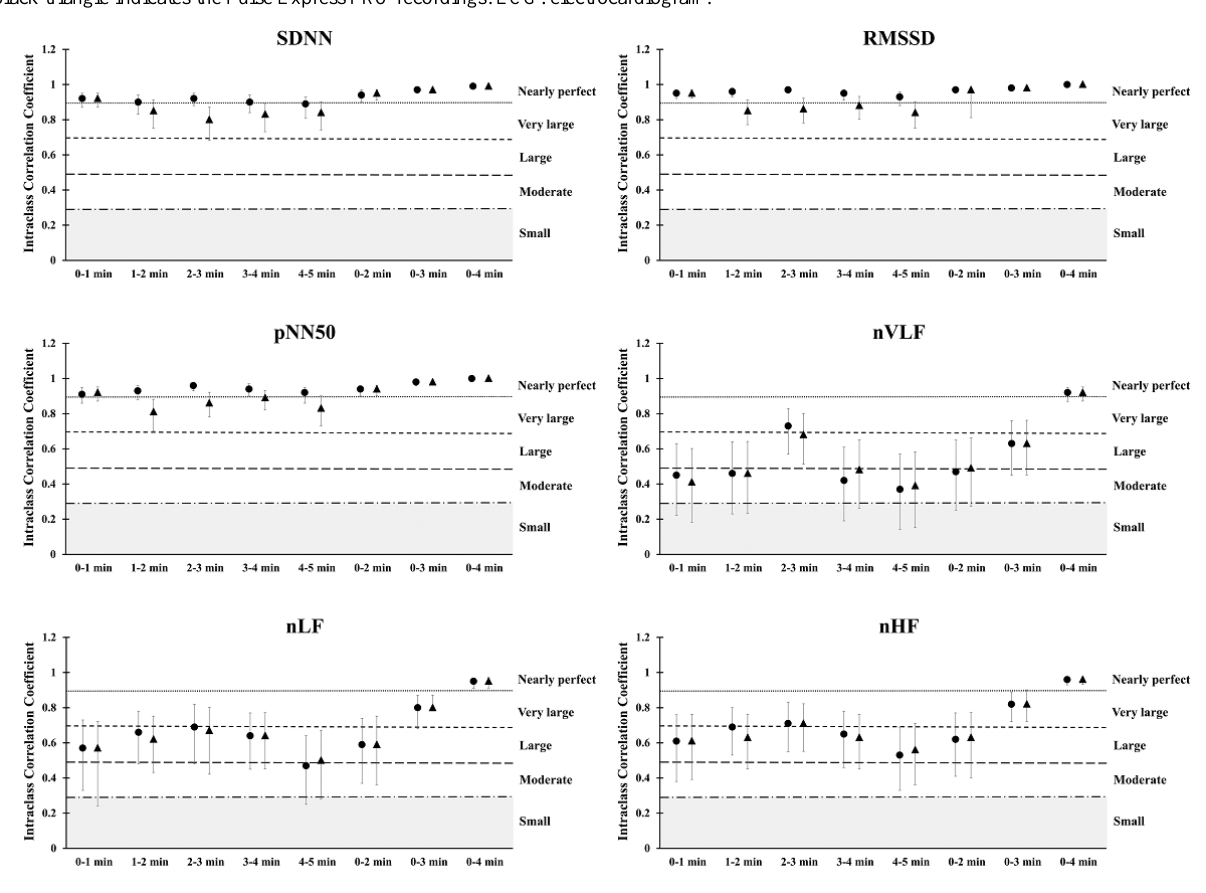
Figure 2. Intraclass correlation coefficients between the ECG and Pulse Express PRO measurements in ultra–short-term and short-term heart rate variability in time-domain and frequency-domain analyses. The grey area indicates low reliability. The black circle indicates the ECG recordings, while the black triangle indicates the Pulse Express PRO recordings. ECG: